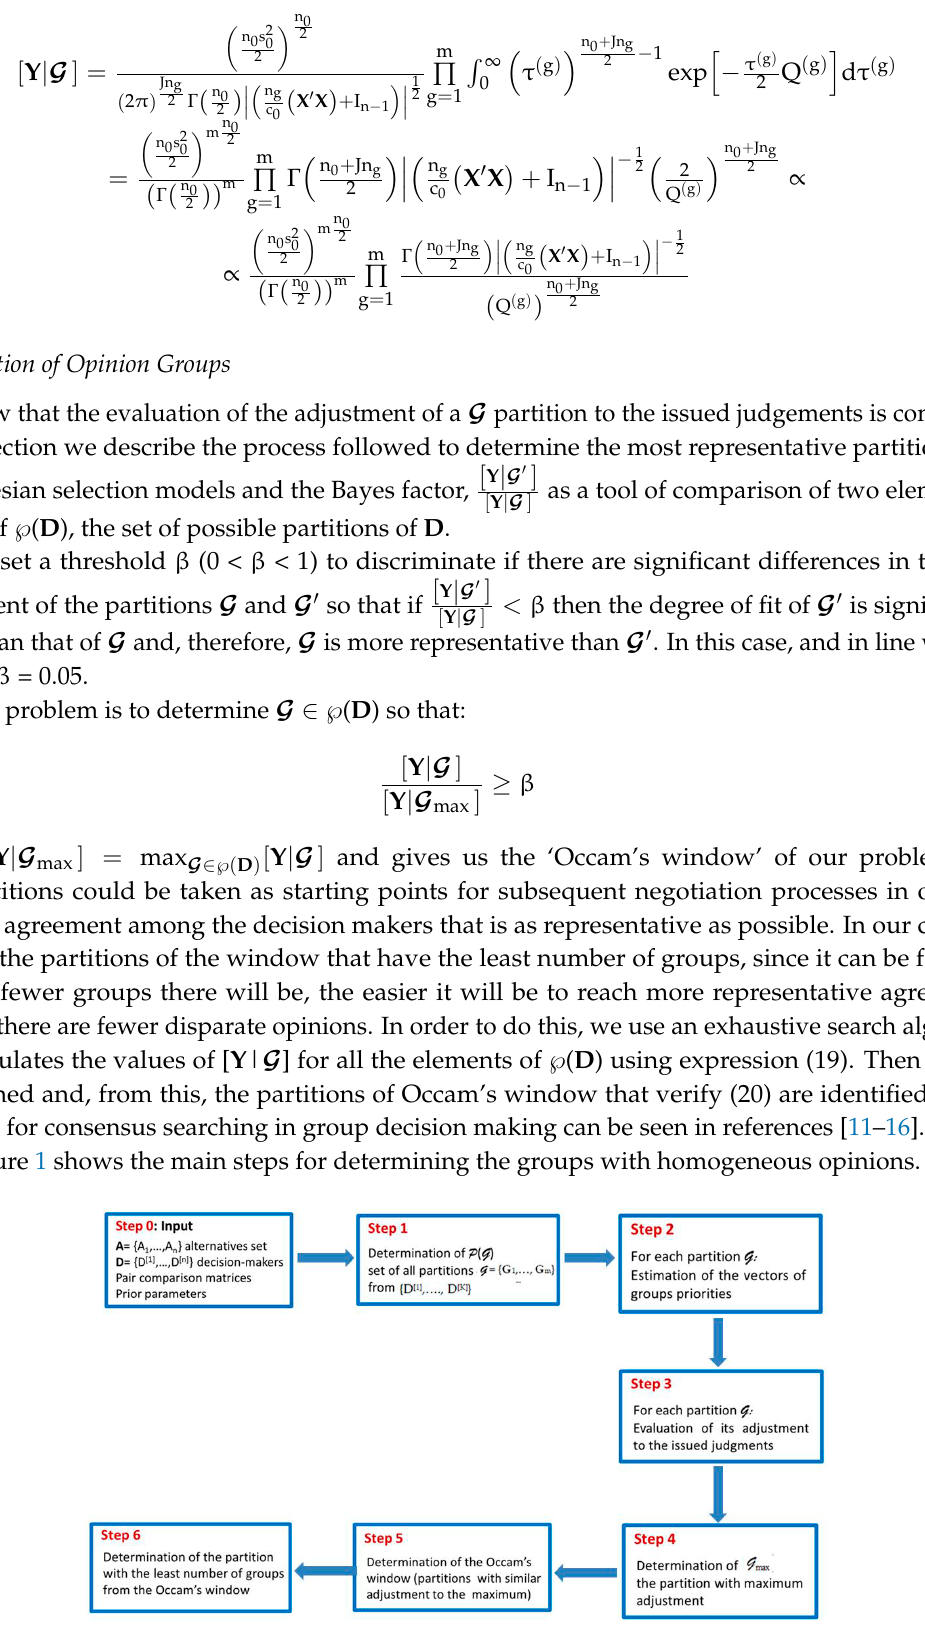
Figure 1. Steps of the proposed methodology.